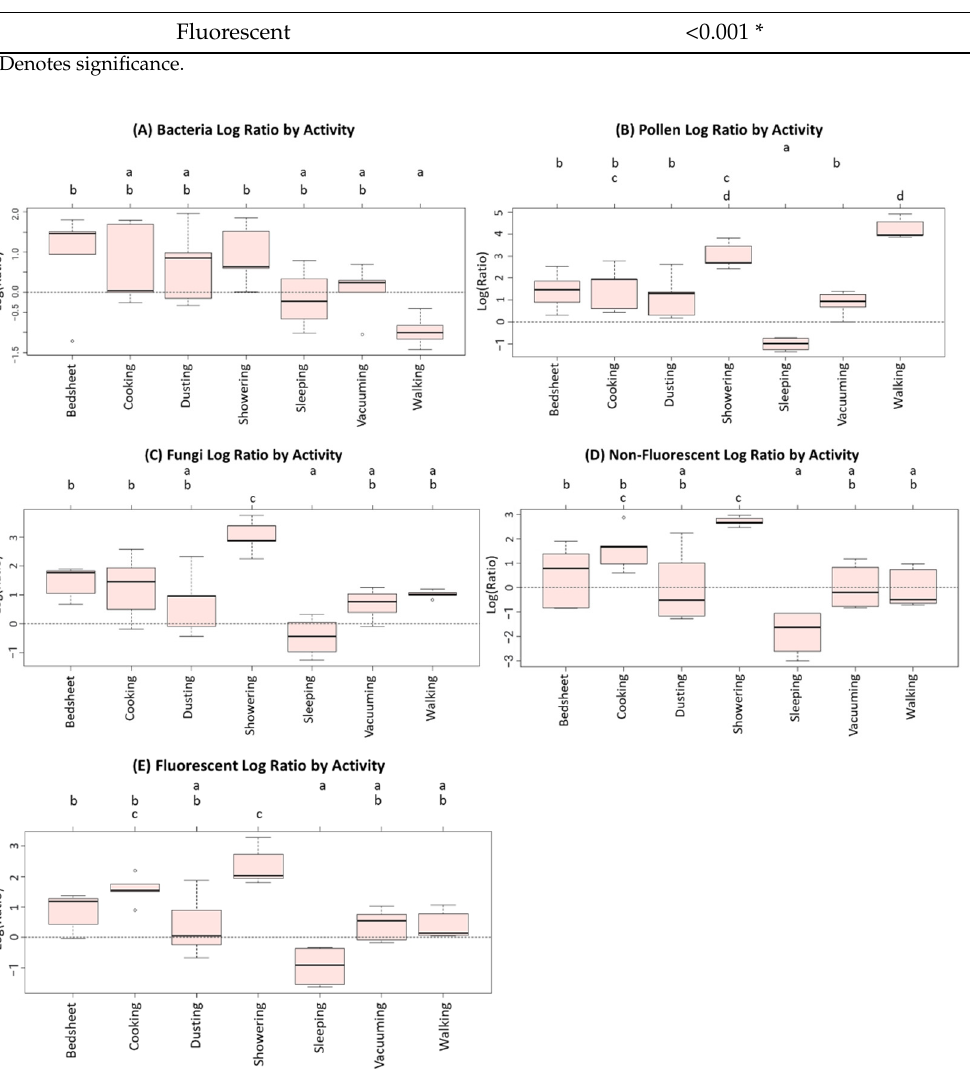
Figure 3. The Compact Letter Display (CLD) graphs portraying pairwise differences between all activities by each particle type. The data behind the comparisons are the natural-log transformed concentration ratios. The graphs are indexed by five particle types ( A = Bacteria, B = Pollen, C = Fungi, D = Non-Fluorescent, E = Fluorescent). In each CLD graph, the five-point box plot shows the minimum, first quartile, median, third quartile, and maximum of five data points for each activity (except sleeping, n = 4). The dotted line in each CLD graph shows log-ratio of zero (or equivalent anti-log ratio of one). Any two treatments receiving the same letter at the top of the graphs are not significantly different as per Tukey’s HSD method.